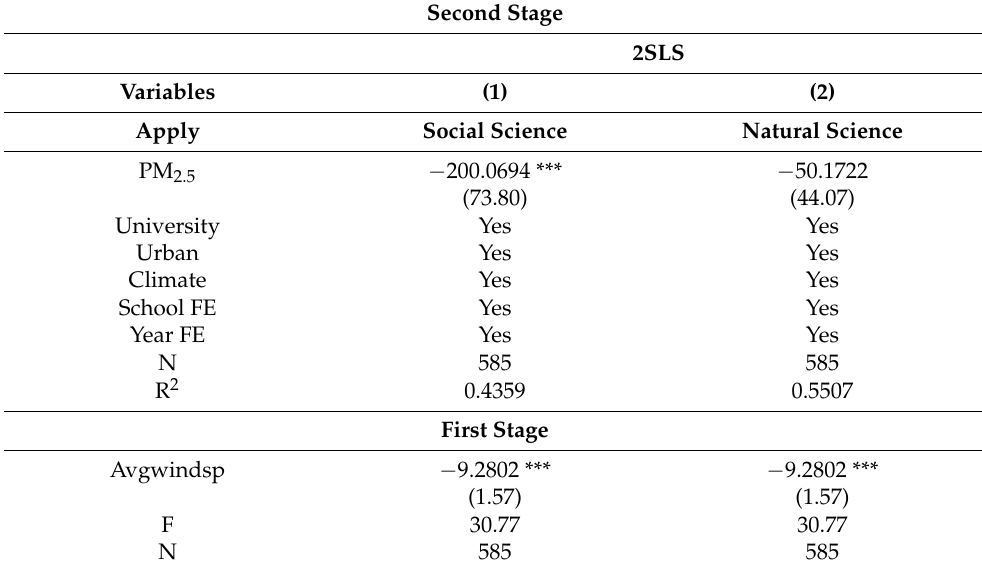
Table 4. Different discipline